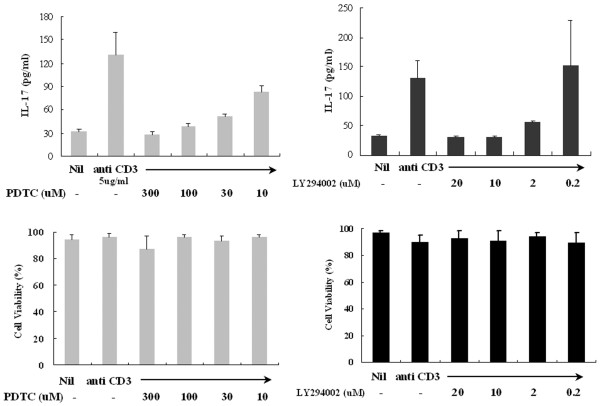
Dose-dependent effects of LY294002 or pyrrolidine dithiocarbamate (PDTC) in peripheral blood mononuclear cells (PBMC) from patients with rheumatoid arthritis (RA). (a) Effect of inhibitors on interleukin (IL)-17 release by anti-CD3-stimulated PBMC from patients with RA. (b) Effects of LY294002 or PDTC on PBMC viability. PBMC were cultured at a concentration of 2 × 105 cells per well with medium, anti-CD3, anti-CD3 and LY294002 or PDTC under the conditions described in the Materials and methods section. After 24 hours of treatment, cell viability was assessed by the trypan blue dye exclusion method and expressed as a percentage with the formula 100 × (number of viable cells/number of both viable and dead cells).